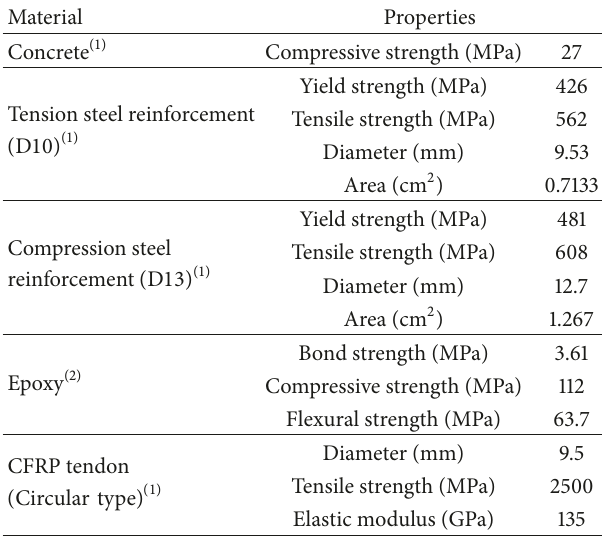
Table 1: Summary of material